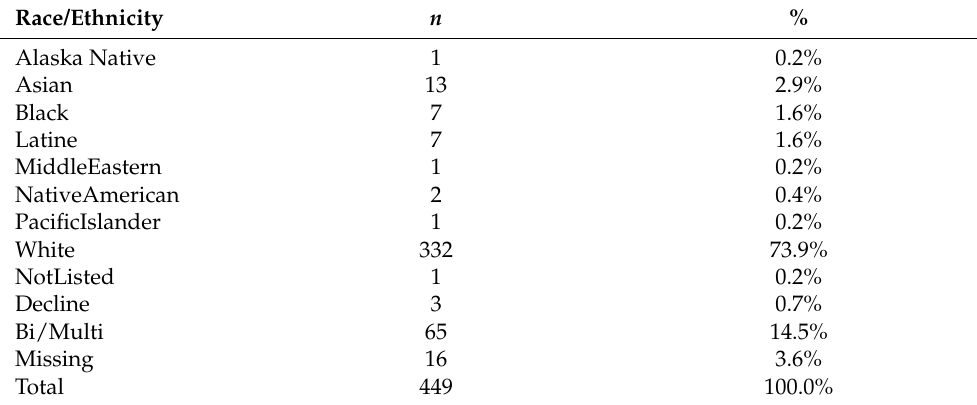
Table 1. Respondent racial/ethnic identity.